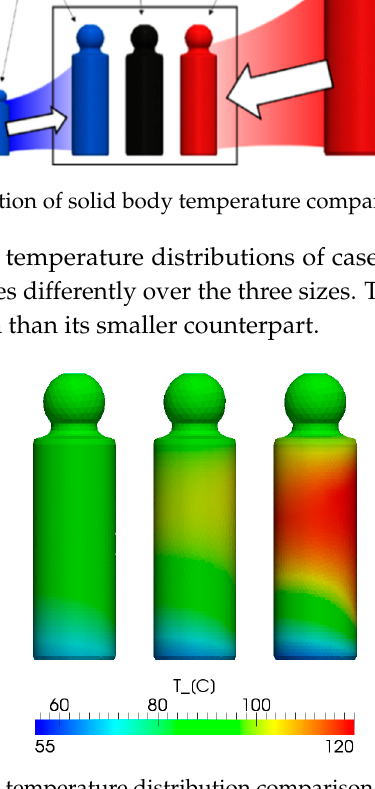
Figure 18. Cylinder block temperature distribution comparison for different sizes.